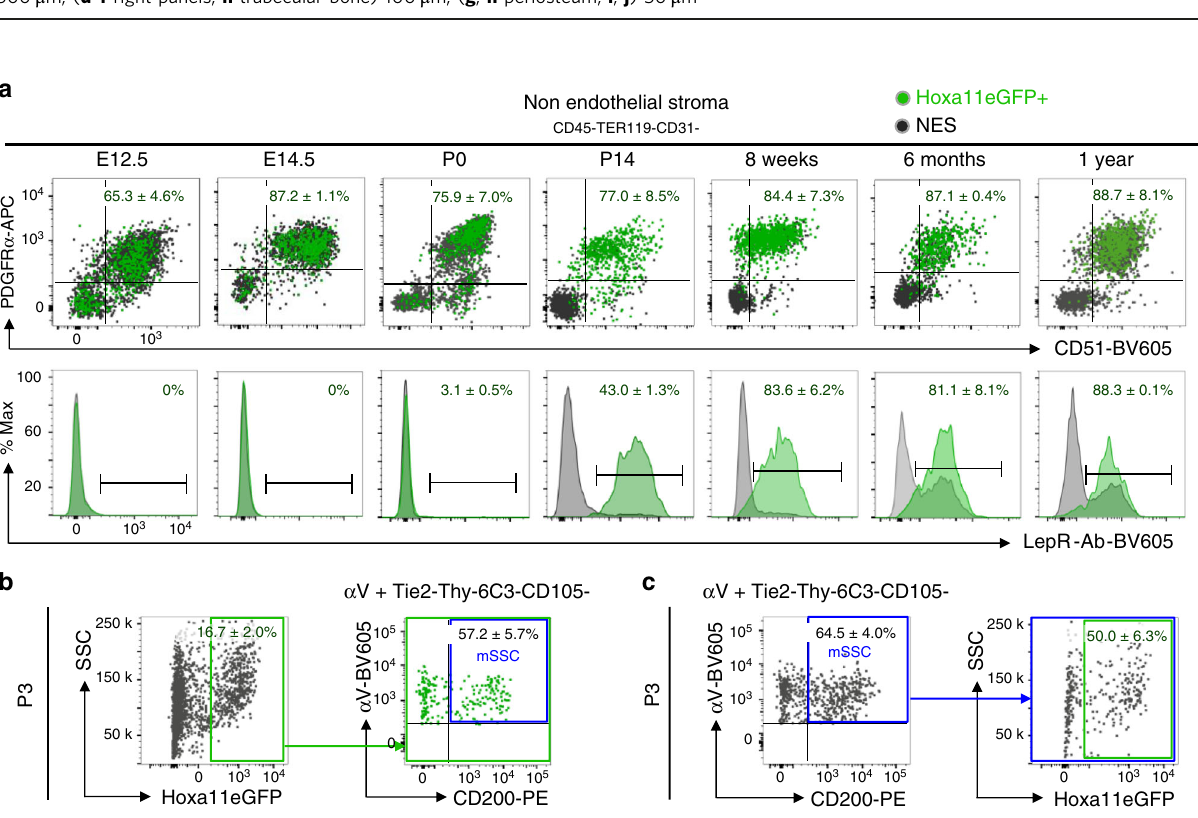
Fig. 1 Hoxa11eGFP expression de fi nes a continuous stromal population. a – f Hoxa11eGFP expression in the forelimb zeugopod (radius and ulna) shown from embryonic to adult stages with proximal on left and distal on right in all images. Hoxa11eGFP expression in radius and ulna a – c , higher magni fi cation images show cartilage marker, Sox9 at E13.5 ( a , red) and osteoblast marker, Osterix at E14.5 ( b , magenta). d – f Mid-diaphysis radius (r) and ulna (u) (higher magni fi cation images of mid-diaphysis ulna, white dashed box, shown on right). g Hoxa11eGFP and Osterix (red) at 8 weeks, white arrowheads identify individual Osterix positive nuclei. h Hoxa11eGFP (green) in E15.5 distal growth plate and higher magni fi cation of perichondrium (white boxed region, bracket), 8 weeks periosteum (bracket), and P4 trabeculae. i , j Periosteal Hoxa11eGFP and Periostin (red) at 2 week ( i ) and 8 weeks ( j ). Dashed white lines mark periosteal boundary, dotted line separates inner and outer layers. j Cell marked by asterisk magni fi ed in inset. In all images, green: Hoxa11eGFP, gray: DAPI. Bone marrow: bm, periosteum: po, endosteum: endo, cortical bone: cb, perichondrium: pc. Scale bars: ( a , b , d – f left panels, h growth plate), 200 μ m,